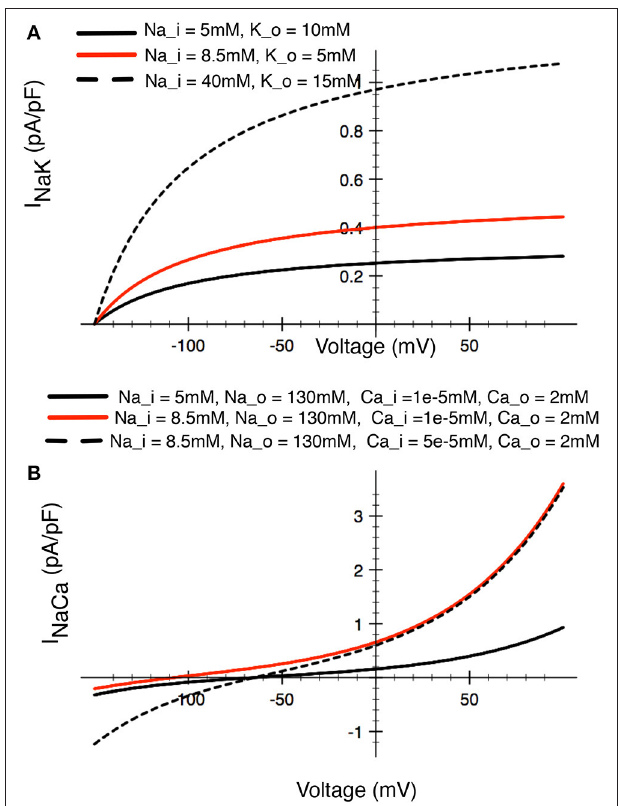
FIGURE 7 | Illustrations of the relative sizes of net currents produced by (A) the Na + /K + pump, and (B) the Na + /Ca 2 + exchanger in a human chondrocyte. The three superimposed I–V curves for the Na + /K + pump illustrated in (A) bracket the [Na + ] and [K + ] levels that have been reported in the literature (see Table 1 ). The red trace would approximately correspond to baseline conditions for [Na + ] and [K + ] in other mammalian cells. The three superimposed I–V curves for the Na + /Ca 2 + exchanger in (B) illustrated the relative magnitudes for this current, with the red trace again approximating the resting or baseline I Na Ca current in most other mammalian −